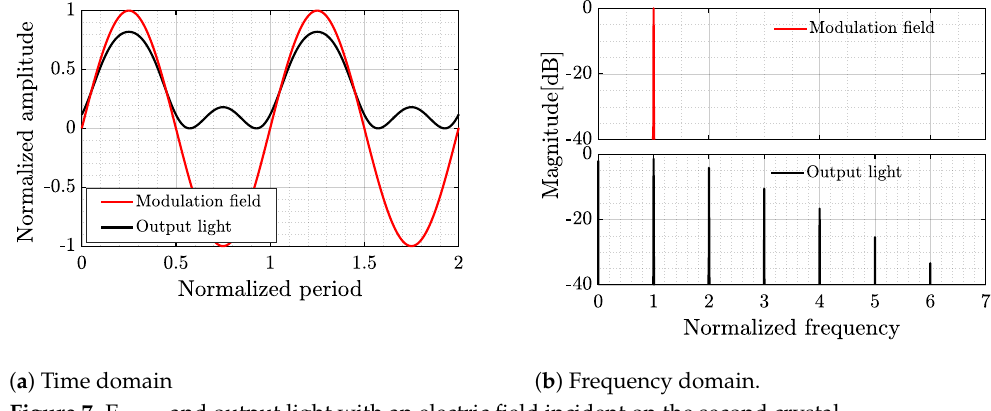
Figure 7. E MOD and output light with an electric field incident on the second crystal. With the sensing crystal exposed to an external electric field, odd harmonics of the modulation frequency appear in the output light intensity signal. In particular, the power of H1 increases proportionally with the external electric field intensity, as shown in Figure